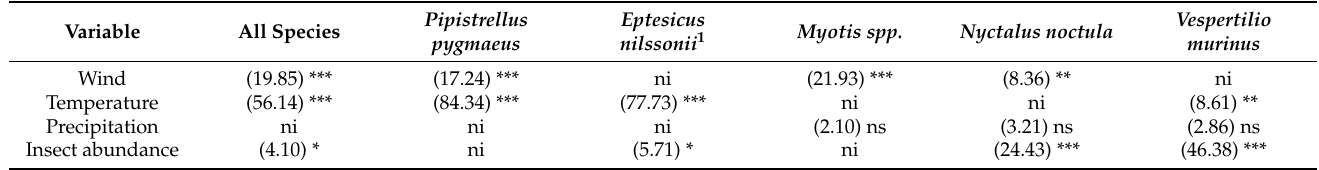
Table 3. Results from the multiple Poisson regressions, where the total bat activity or the activity of the five most common taxa were used as the response variable. n = 87 nights (from SWT at nacelle height in 2017). Numbers in parenthesis are the Wald χ 2 test statistic. * = p < 0.05, ** = p < 0.01, *** = p < 0.001, ns = not significant but included in the model with the lowest AIC, ni = not included in the model with the lowest